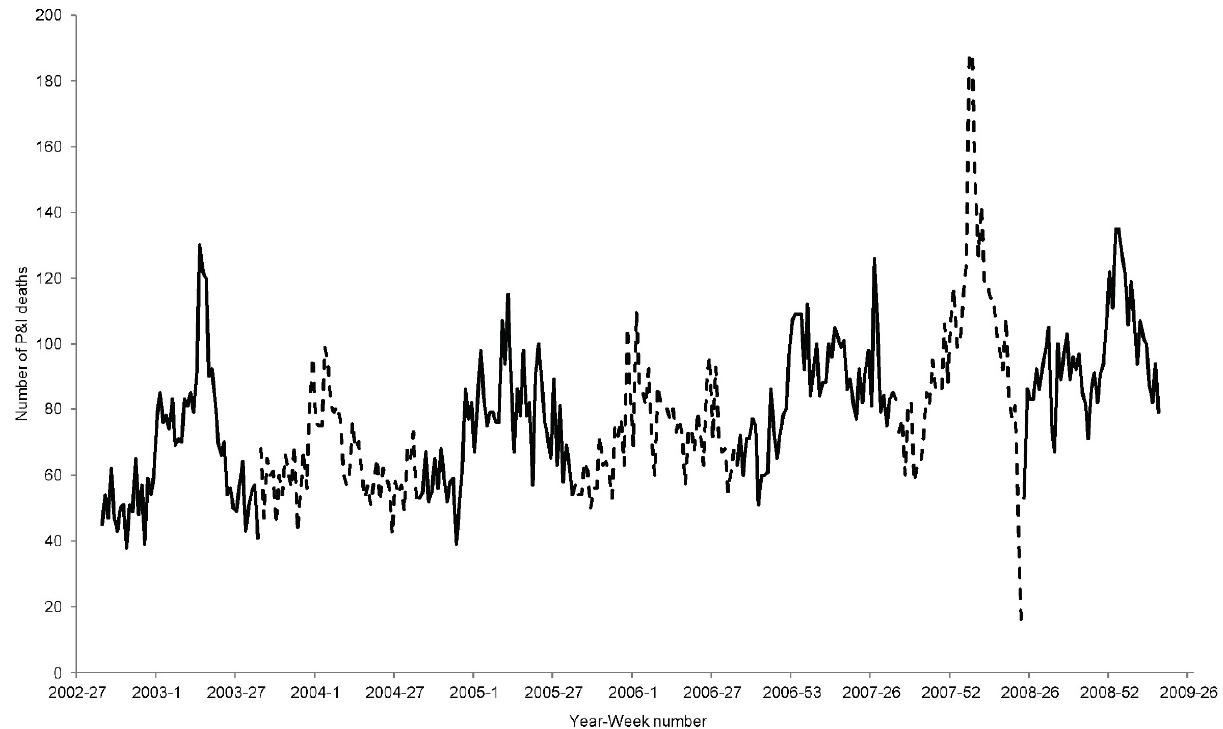
Figure 1. Number of P&I deaths from 2002 to 2009 in Hong Kong. The alternating solid and dashed line separates the yearly